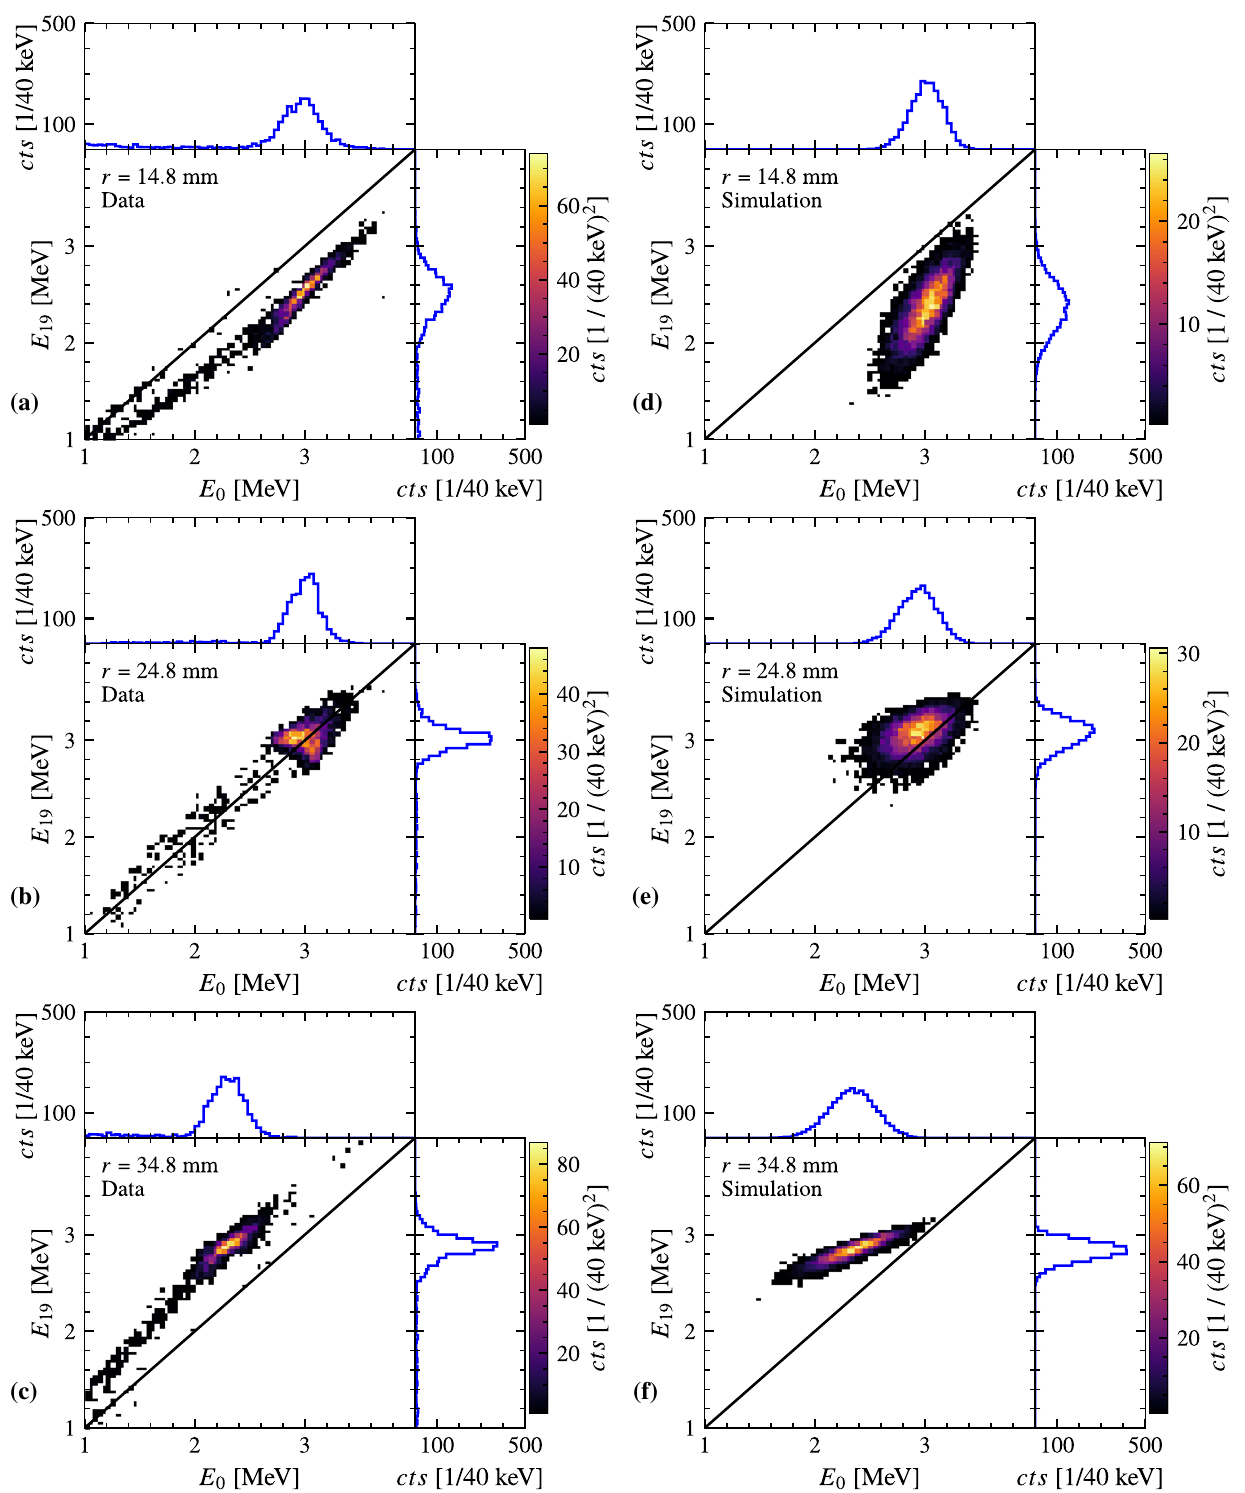
Fig. 20 Correlation between core and segment 19 energies and their marginalisations next to them. On the left a – c : alpha events selected as described in Sect. 3 of three measurements from RSF. On the right